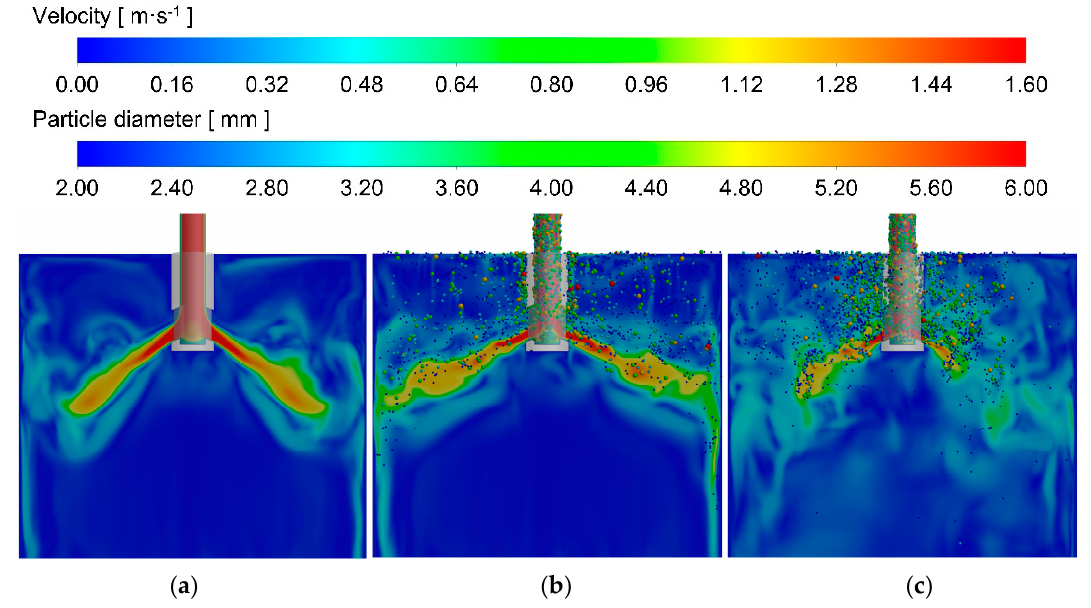
Figure 9. Contour diagram of instantaneous velocity and distribution of argon bubbles in the mold under EMBr Mode 3 and at different argon flow rates of: ( a ) 0 L·min − 1 , ( b ) 6 L·min − 1 , ( c ) 10 L·min − 1 .